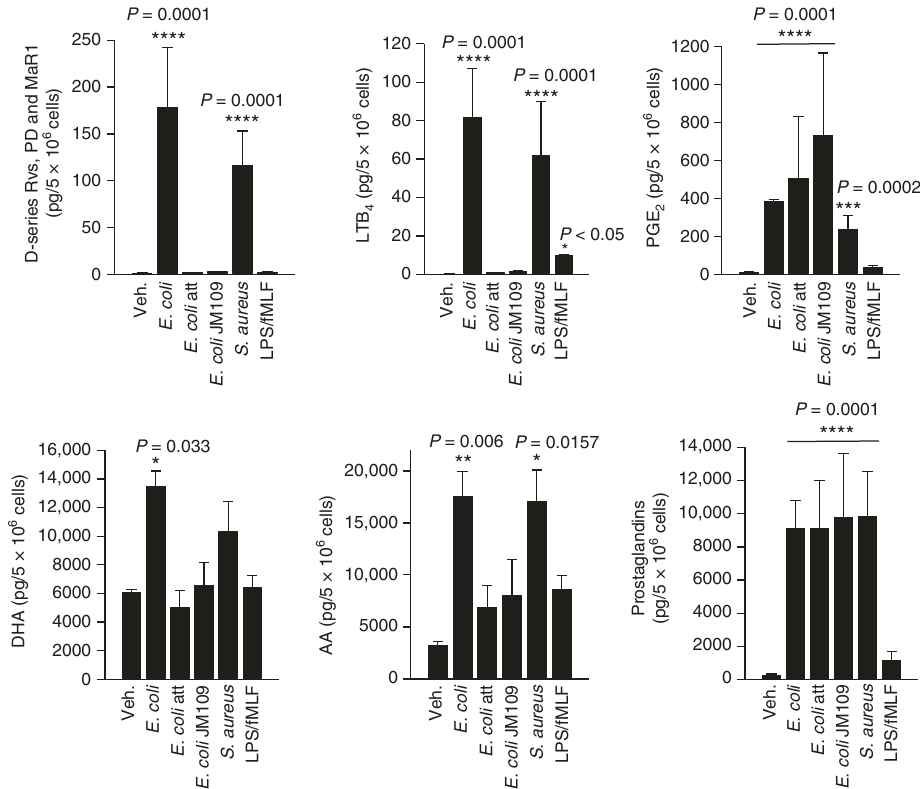
Fig. 4 M2 macrophages release speci fi c lipid mediators in response to pathogenic bacteria. Human monocyte-derived M2 (5 × 10 6 cells/ml PBS + Ca/Mg) was incubated with E. coli (O6:K2:H1), attenuated E. coli (O6:K2:H1), non-pathogenic E. coli strain JM109, or S. aureus (ratio macrophages:bacteria 1:50, each) at 37 °C for 180 min, or with 100 ng/ml LPS plus 100 nM fMLF for 60 min. Lipid mediators were isolated by SPE and analyzed by LC – MS – MS. D-series resolvins include RvD1, RvD2, RvD5, and RvD6, and prostaglandins include PGD 2 , PGE 2 , and PGF 2 α . Results are given as means ± S.E.M., n = 3 separate donors. * P < 0.05, ** P < 0.01,*** P < 0.001, and **** P < 0.0001 vs. vehicle control (veh.), data were log transformed for statistical